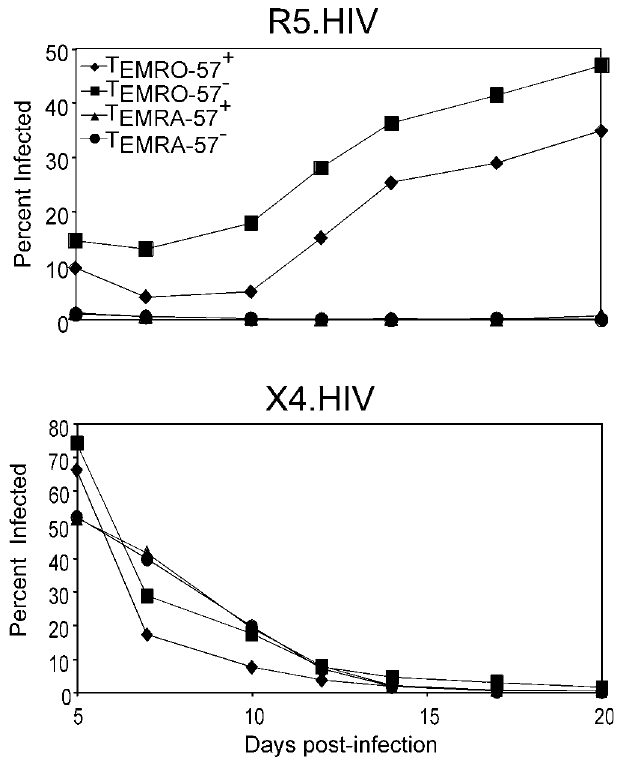
Figure 6. Replication of HIV-1 strains in CD57 þ CD4 þ T cell subsets Effector memory T cell subsets were subdivided into CD57 þ and CD57 (cid:2) portions by sorting, then activated and concurrently infected with R5.HIV or X4.HIV. The percentage of infected cells was determined by GFP expression at different time points post-infection by flow cytometry. The results are representative of one of five independent experiments from different